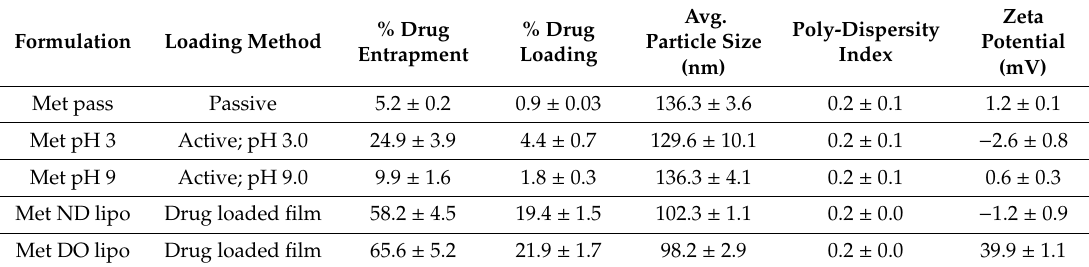
Table 1. Physicochemical characterization of developed liposomal formulations. Data represent mean ± SD ( n =